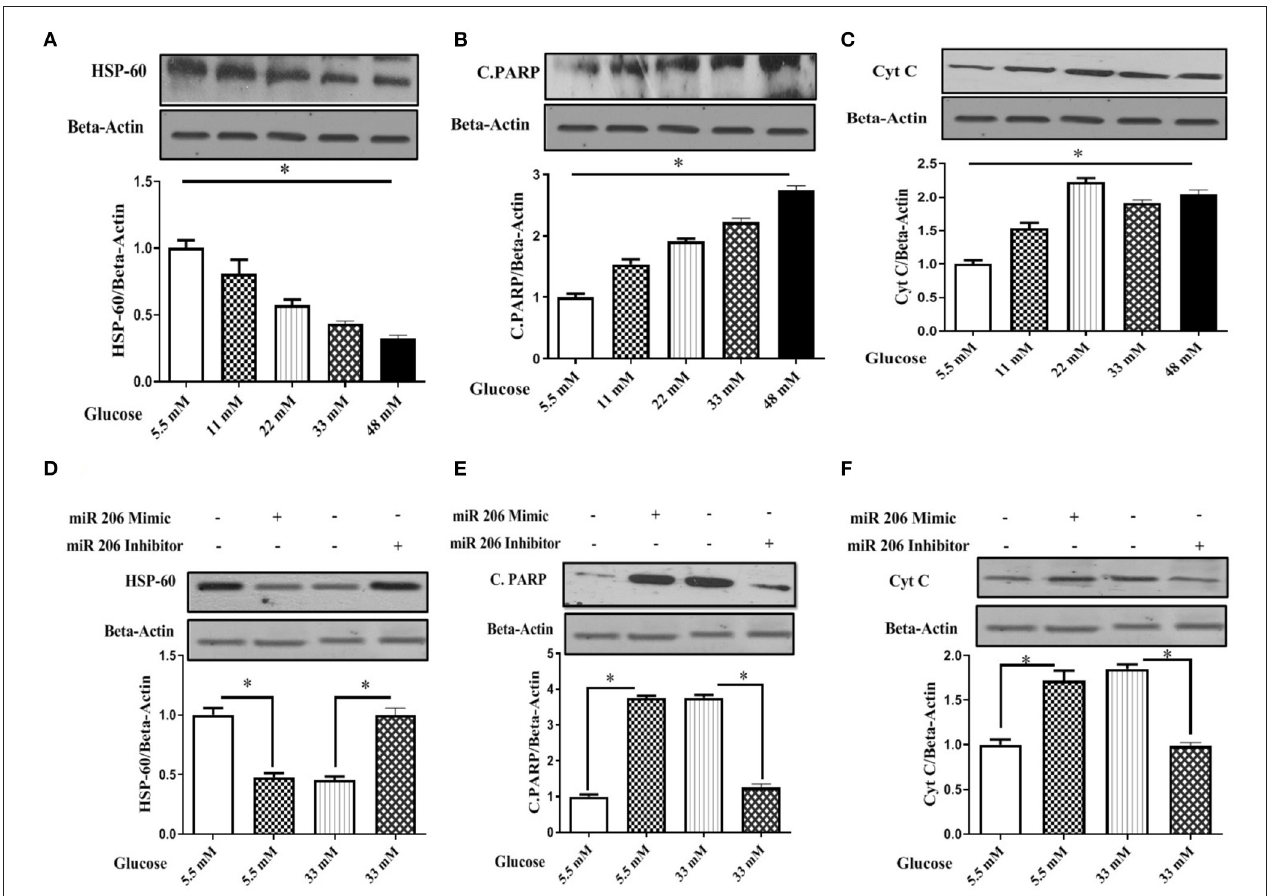
FIGURE 5 | Effect of different glucose concentrations and miR-206 modulation on HSP60 and apoptosis markers in C2C12 cells (A) HSP60 protein expression, (B) Cleaved PARP (C.PARP) protein expression, (C) Cytochrome C protein expression, (D) Effects of miR-206 mimic and inhibitor on HSP60 protein expression, (E) Effects on miR-206 mimic and inhibitor on C-PARP protein expression, (F) Effects of miR-206 mimic and inhibitor on Cytochrome C protein expression. n = 5, C2C12 cells treated for 24h with high glucose DMEM media. *Significant